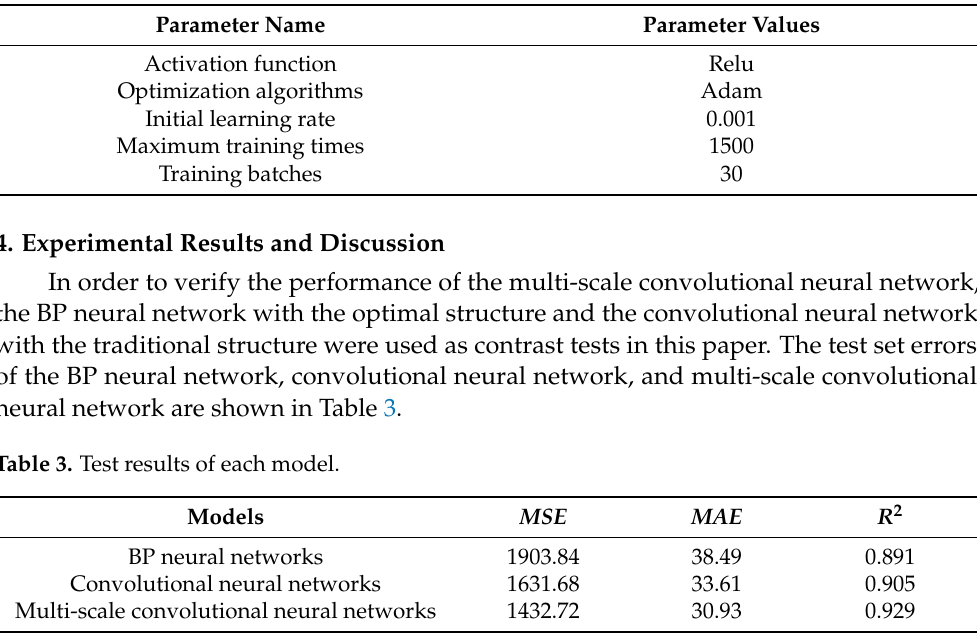
Table 2. Hyperparameters settings.